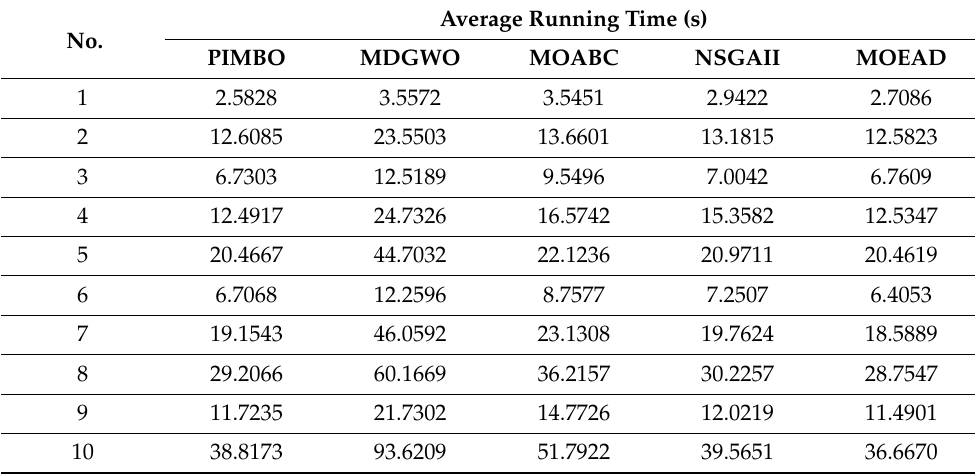
Table 2. The average running time in each instance on five